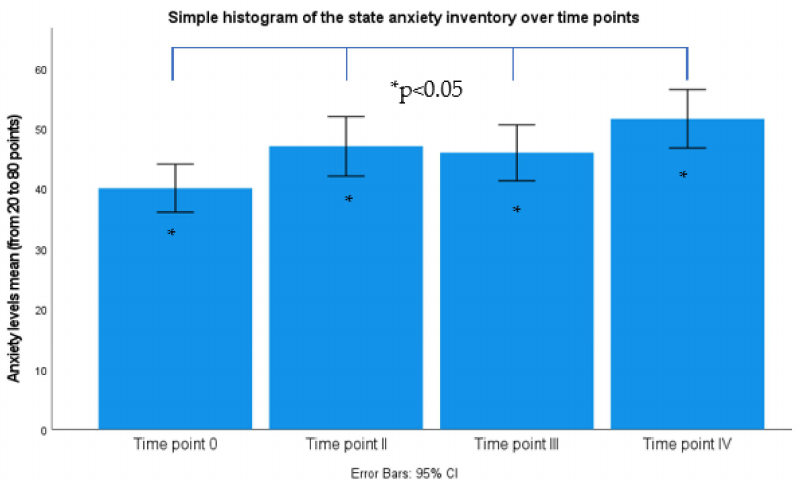
Figure 4. Simple Bar chart summaries of separate variables from anxiety level assessed with state anxiety inventory. Time point 0: 4 weeks prior exam; Time point II: before auriculotherapy; Time point III: 30 min after auriculotherapy and Time point IV: morning before examination, CI: confidence interval.